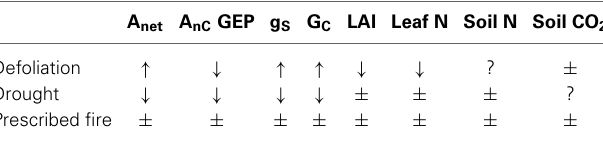
Table 1 | Summary of responses to disturbances in the New Jersey Pine